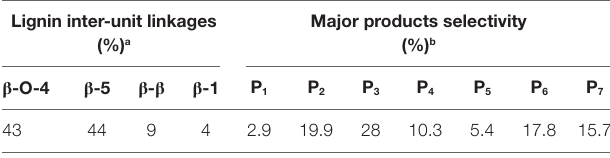
TABLe 2 | Percentage of lignin aromatic inter-unit linkages and the selectivity of the major products via Pd-zeolite Y catalysis. Lignin inter-unit linkages Major products selectivity (%) a (%)